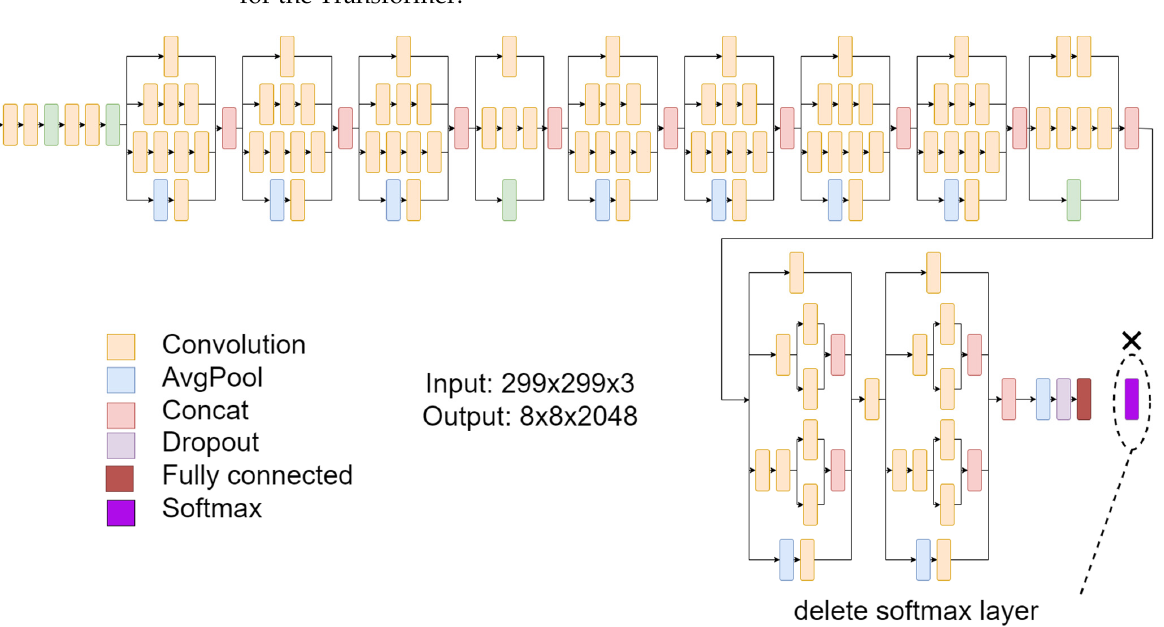
Figure 6. Structure of Inception Modules. We perform various dimensions of convolution operations in parallel to extract the feature map from the Inception Module in a more effective way. In the Inception Module, the 1 × 1 convolution layer plays a key role in reducing dimensions and reducing opera ‐ tions. The InceptionV3 model was improved by changing the optimizer to RMSProp from the InceptionV2 by applying the Label Smoothing technique, which prevents overfitting and Batch Normalization (BN) in the fully connected layers. Those techniques allow InceptionV3 to reduce the complexity while operating with fewer number of parameters, thereby improving accuracy in a shorter period of time. In this study, we removed the SoftMax layer, the last layer of the InceptionV3 model, in order to extract certain feature points of the input images and use them as other inputs for the Transformer.